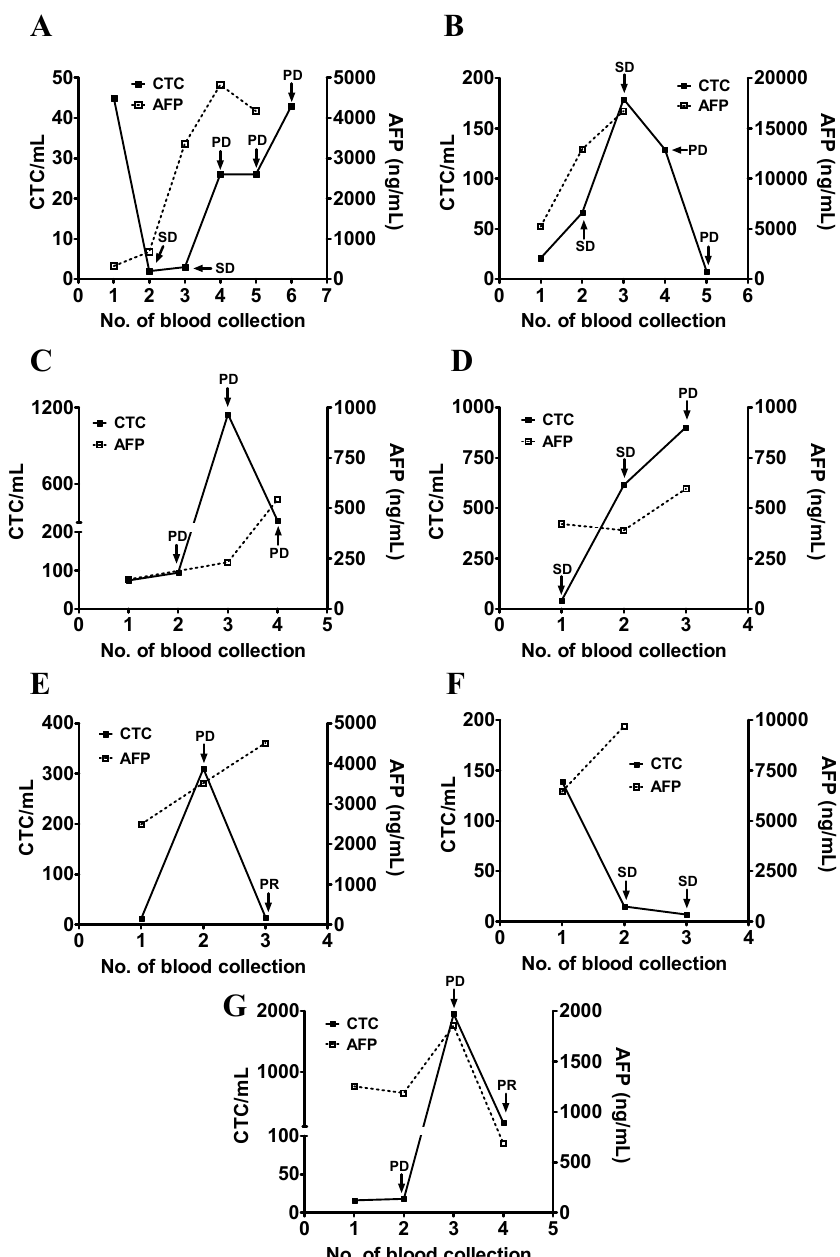
Figure 4. Longitudinal follow-up of the CTC counts for monitoring the disease status of patients with HCC (part II). ( A – G ) The blood samples were longitudinally collected from patients #2 (panel A ), #4 (panel B ), #10 (panel C ), #13 (panel D ), #20 (panel E ), #22 (panel F ), and #28 (panel G ), who all had a high initial serum AFP level followed by an increase. Series testing of the CTC count and serum AFP level were performed and plotted accordingly. The disease status (SD, PR, and PD) was determined and was used as an indicator of the patient’s clinical outcome. Patients #15, #24, and #25 had an initial serum AFP <100 ng/mL, which increased during the course of the study. Patient #15 received sorafenib. The patient’s serum AFP level increased slightly which predicted PD at the third blood collection. The change in the CTC count was consistent with